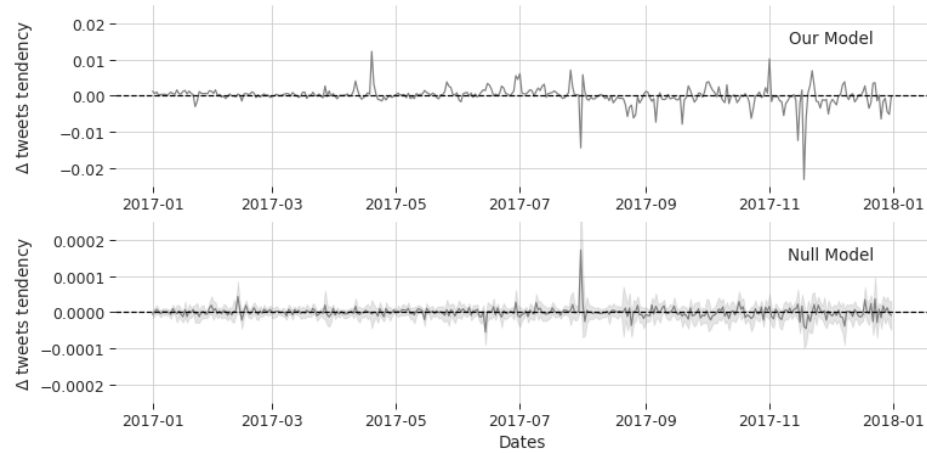
Figure 9. Daily difference in the number of tweets between empathy and threat groups. Top ; our model, and bottom ; the null